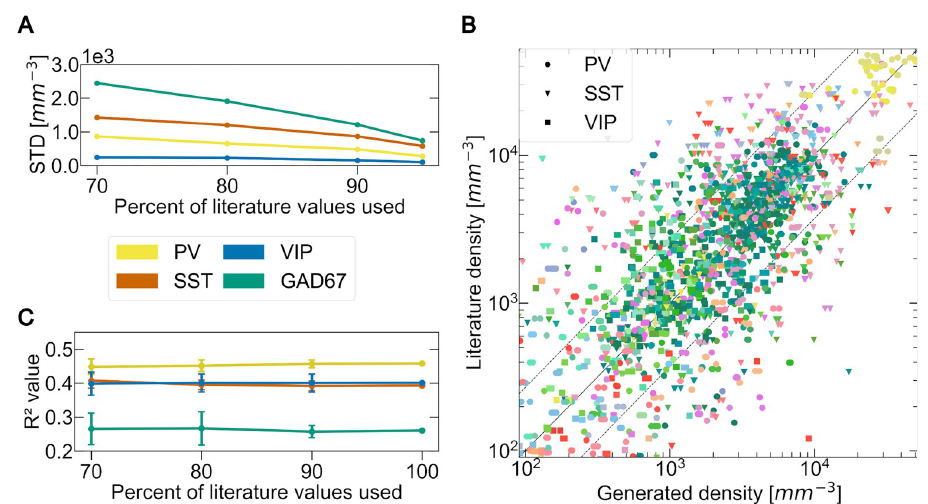
Fig 9. Impact of the amount of literature on the BBCAv2. (A) Evolution of the mean standard deviation of the BBCAv2 generated densities for each genetic marker (shown in different colors) using different percentages of the total amount of literature values available. (B) Comparison of the generated density values of the BBCAv2 with their literature counterparts using 90% of the total amount of literature values available (20 trials). The color encodes the brain regions according to the AV, while the shapes of the points encode for cell types. The middle line delimits equal quantities, while the dashed line shows the average deviation of 2.7-fold between literature values reporting on the same region for PV, SST and VIP neurons. (C) Evolution of the mean coefficient of determination R 2 of the fitting, for each genetic marker (shown in different colors), performed using different percentages of the total amount of literature values